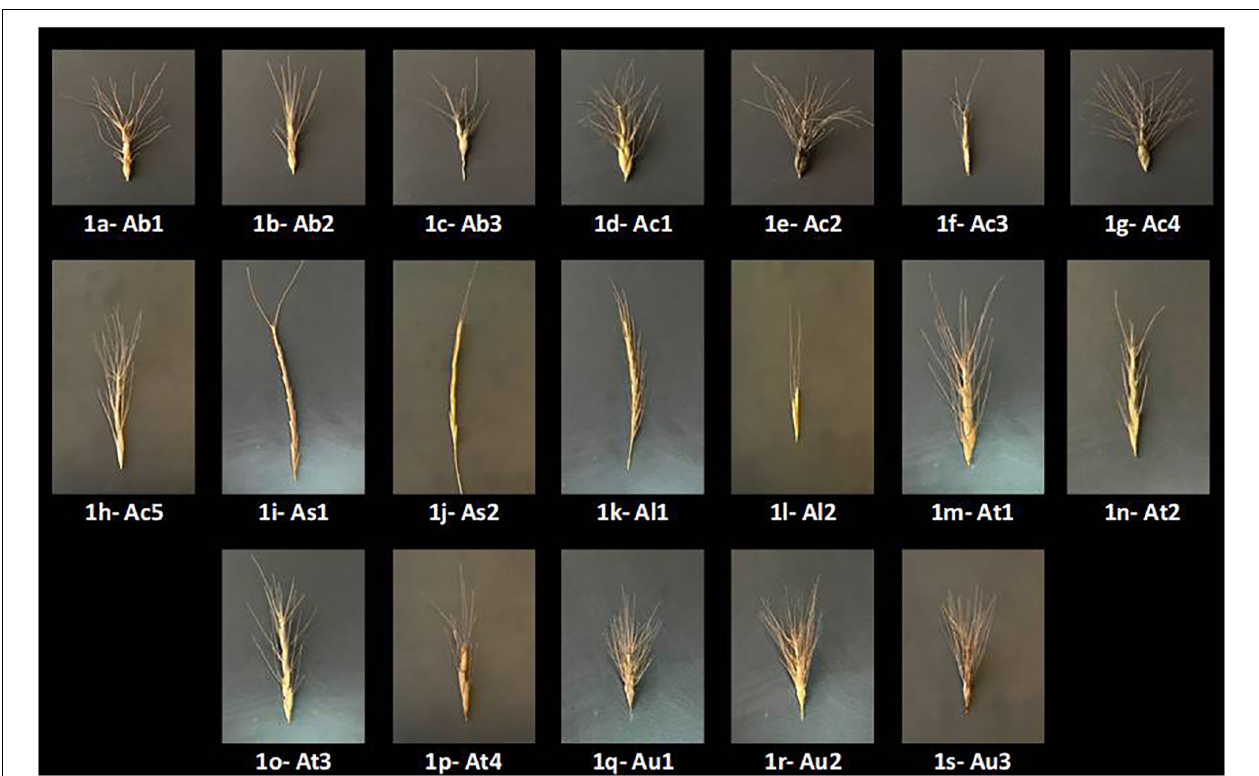
FIGURE 1 | Pictures of the 19 Aegilops accessions provided by the Turkish Seed Gene Bank (TSGB), Ankara, and AARI National Gene Bank, ˙Izmir, Turkey. (a) Ab1 ( Aegilops biuncialis 1: TGB 026218; 4x); (b) Ab2 ( A. biuncialis 2: TGB 026219; 4x); (c) Ab3 ( A. biuncialis3 : TGB 037313; 4x); (d) Ac1 ( A. columnaris1 : TGB